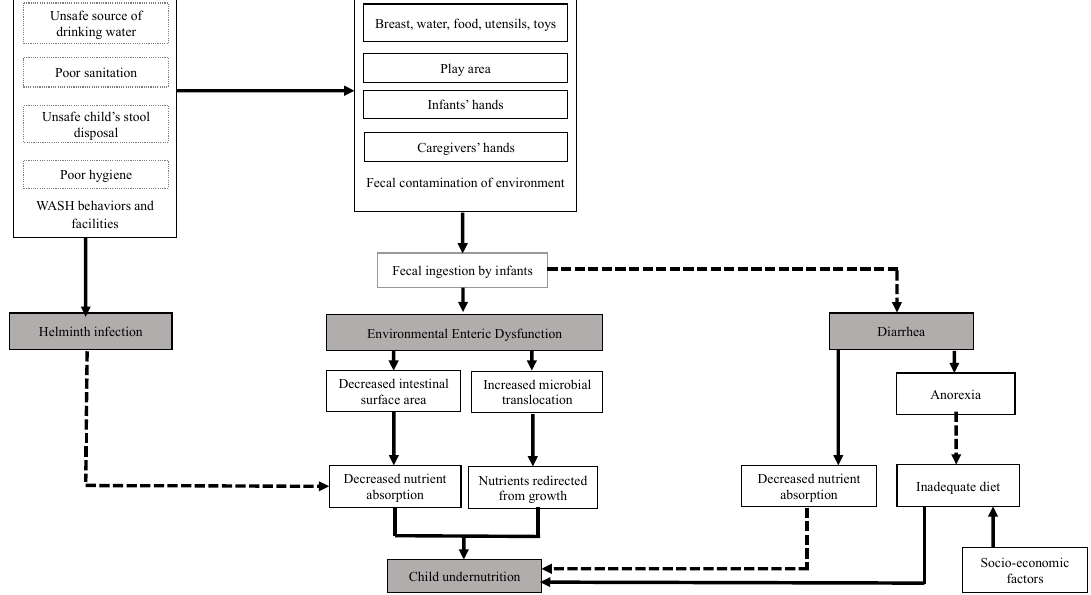
Figure 1. Pathways linking water, sanitation, and hygiene (WASH) conditions and child undernutrition. Adapted from Humphrey [15] and Dangour et al. [17]. Solid lines represent primary pathways and dotted lines represent secondary pathways.